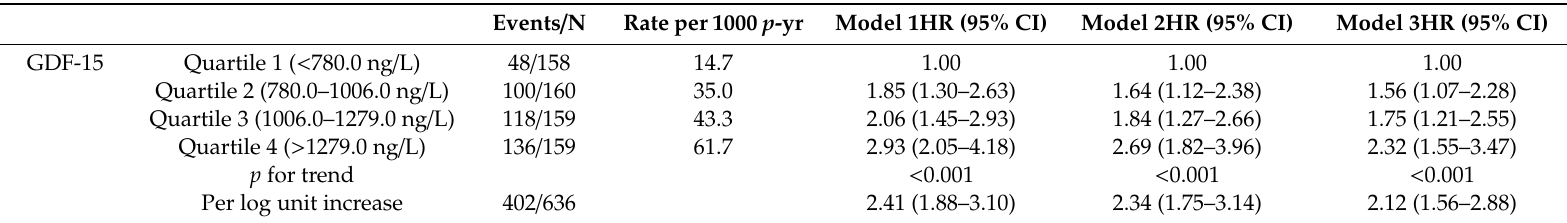
Table 3. Association between GDF-15 concentration at baseline and risk of long-term all-cause mortality in subjects with